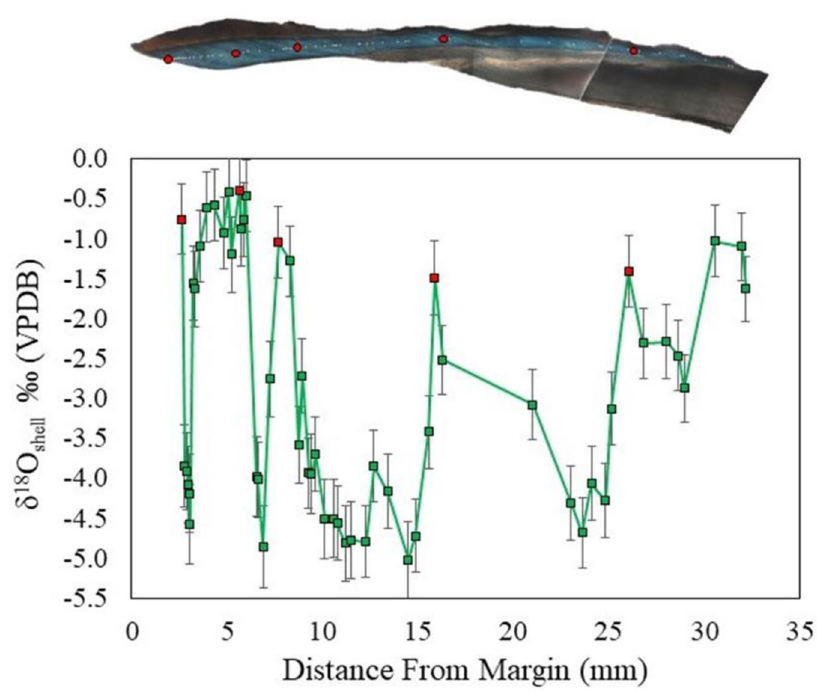
Fig. 2 Oxygen isotope pro fi le of historical shell specimen. A shell cross-section and the associated oxygen isotope pro fi le ( δ 18 O) of a Hawaiian limpet ( C. sandwicensis ), reported in permille ( ‰ ) relative to the international VPDB standard, were measured sequentially along the growth axis — starting at the shell margin. This pattern in the δ 18 O pro fi le of the historical shell (BPBM — green line) re fl ects the recorded seasonality in intertidal SST. The positive δ 18 O measurements (red squares) were taken along and correspond with major bands (red circles) in the shell cross-section. Error bars represent measurement error 2 sigma (2 σ ), which re fl ects both precision (2 standard error) and reproducibility (2 standard